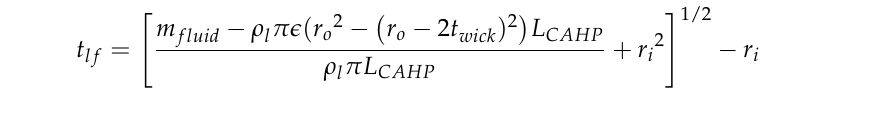
Table 3. Thickness of liquid film in the CAHP according to volume fraction. Total Mass of Working Fluid Volume Fraction [%]